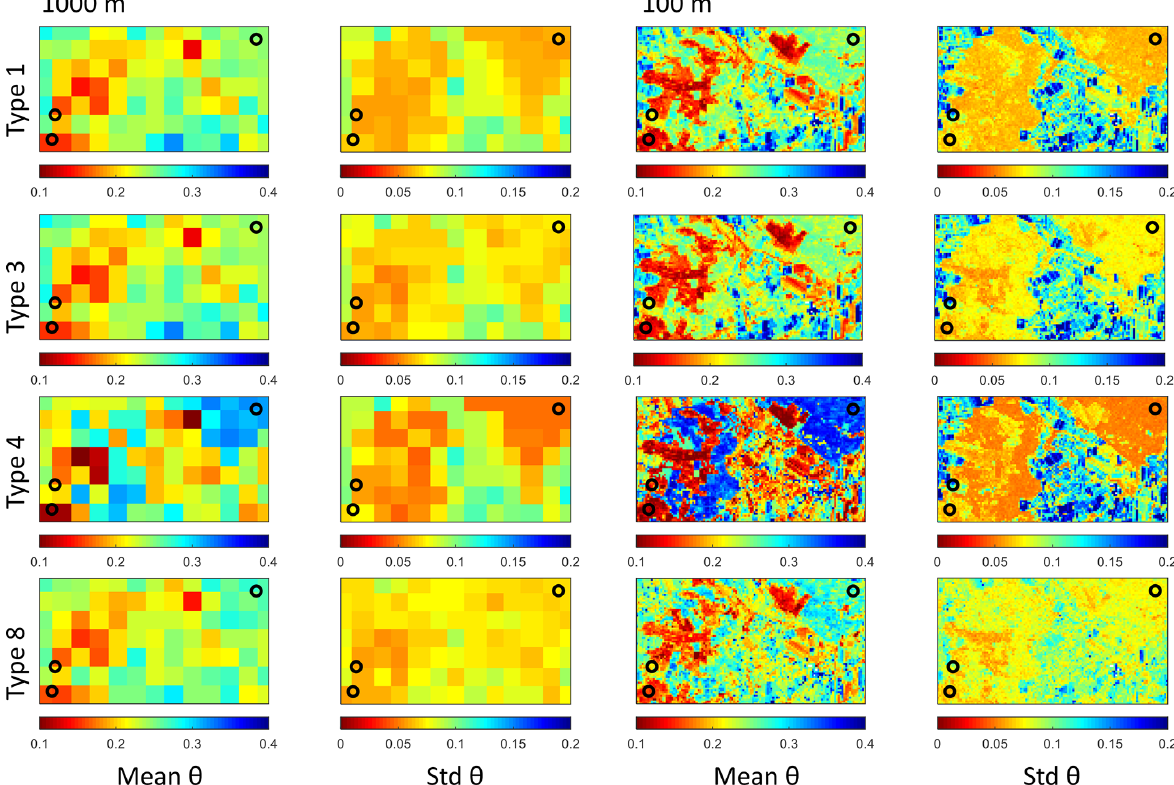
Figure 9. Downscaling results at the 1000 and 100m spatial resolution: spatial pattern of the mean and standard deviation of downscaled soil moisture shown for types 1, 3, 4 and